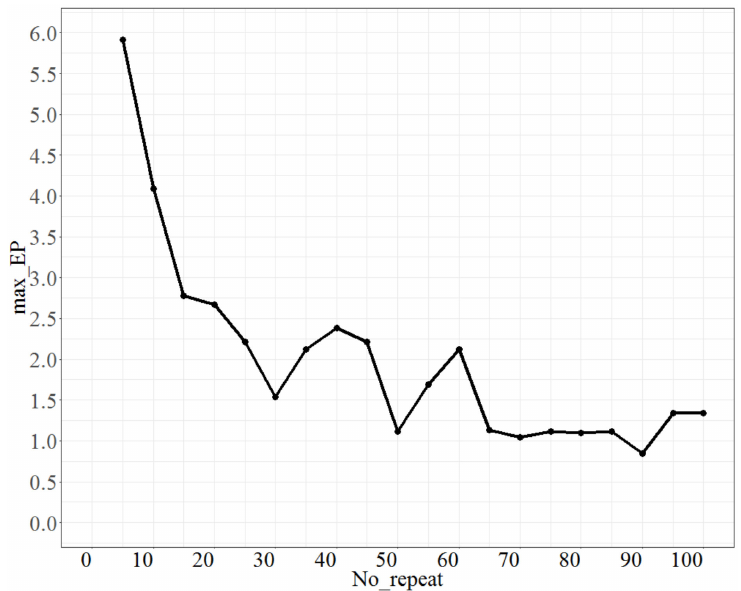
Figure 3. The behaviour of max_EPs as No_repeat